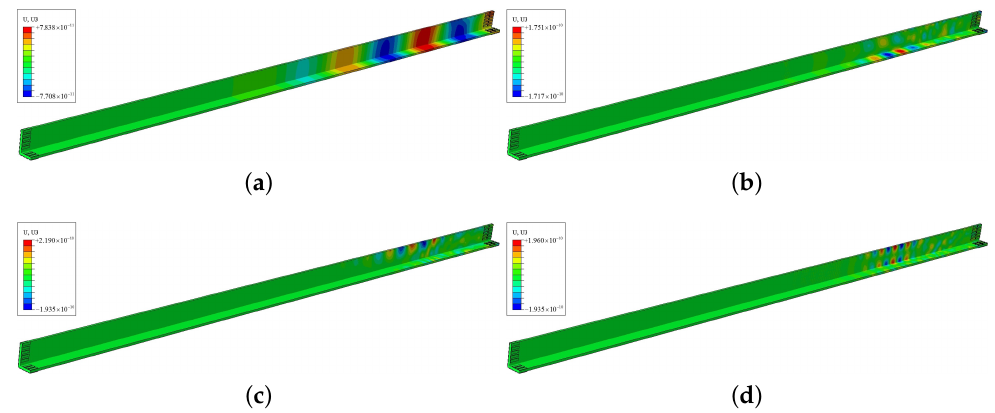
Figure 12. Static images during the propagation of guided waves in FE at: ( a ) 25 kHz M4, ( b ) 80 kHz M9, ( c ) 100 kHz M11, ( d ) 155 kHz M13.